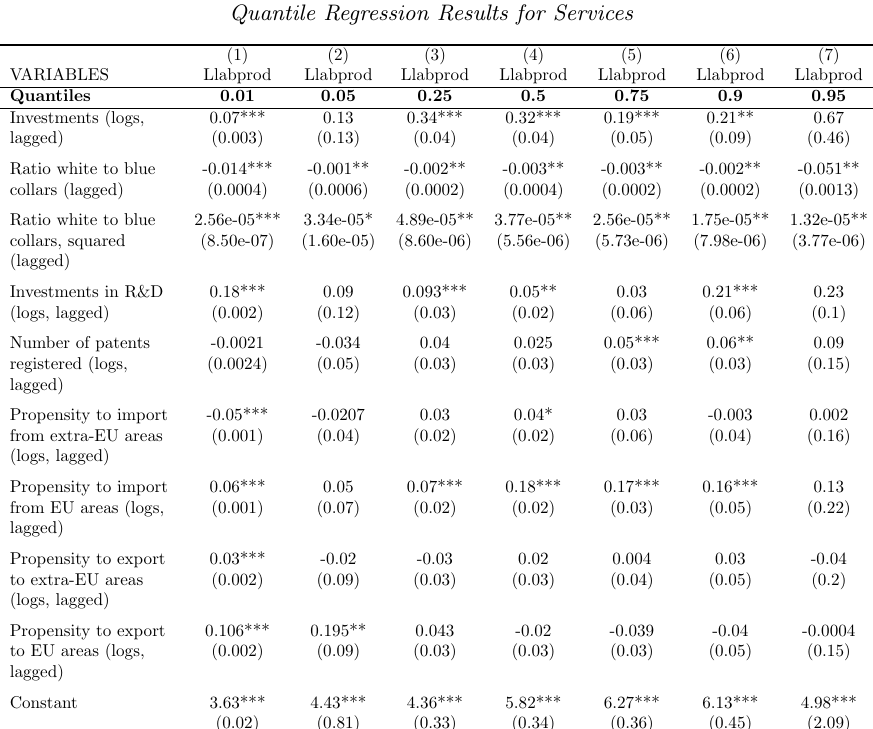
Quantile Regression Results for